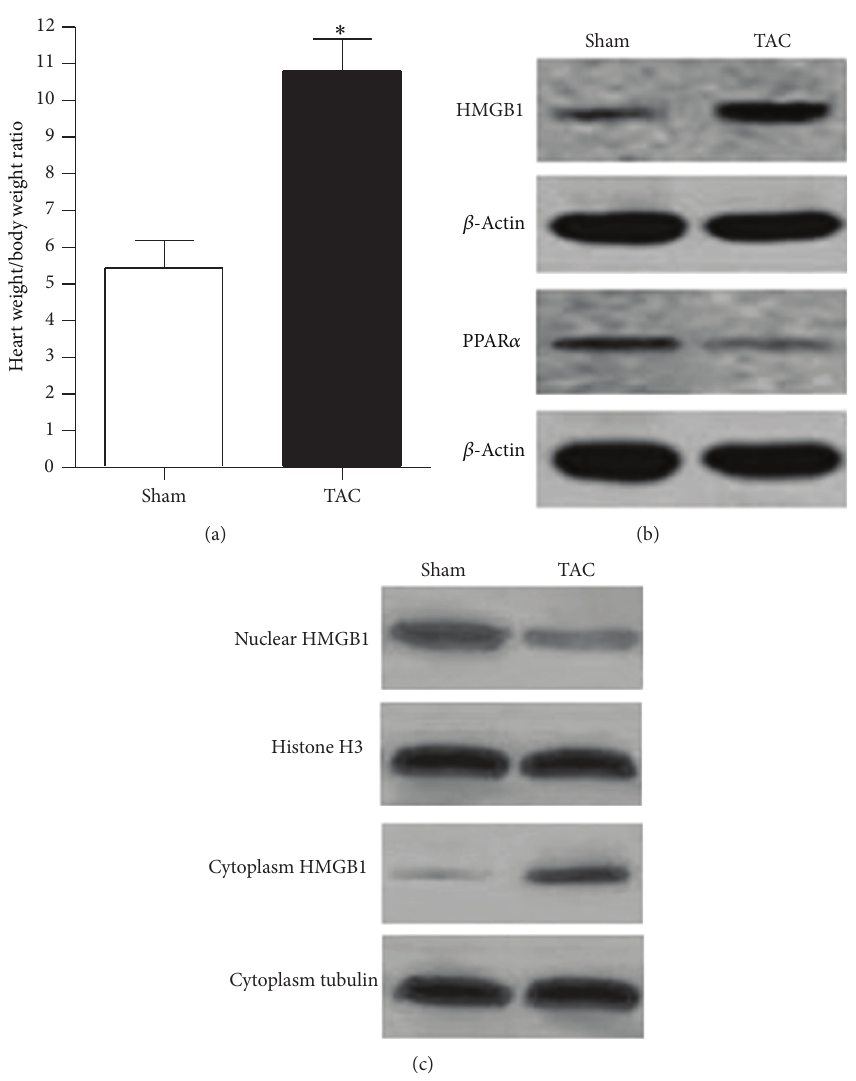
Figure 3: Decreased expression of PPAR 𝛼 and increased expression of HMGB1 in hypertrophic hearts induced by TAC. (a) Heart weight : body weight in TAC and sham-operated mice at 4 weeks after the operation. (b) Decrease in PPAR 𝛼 and increase in HMGB1 at the protein level in cardiomyocytes after the TAC operation; western blot was performed to analyze the expression of PPAR 𝛼 and HMGB1, and 𝛽 -actin was used as the loading control. (c) Translocation of HMGB1 from the nucleus to the cytoplasm after the TAC operation; histone H3 andcytoplasmictubulinwereusedasloadingcontrolsfornuclearproteinandcytoplasmprotein,respectively.Allofthedataarerepresentative of at least three independent experiments. The data in (a) are presented as the mean ± SEM for five mice from each group. ∗ 𝑃 < 0.05 versus sham-operated